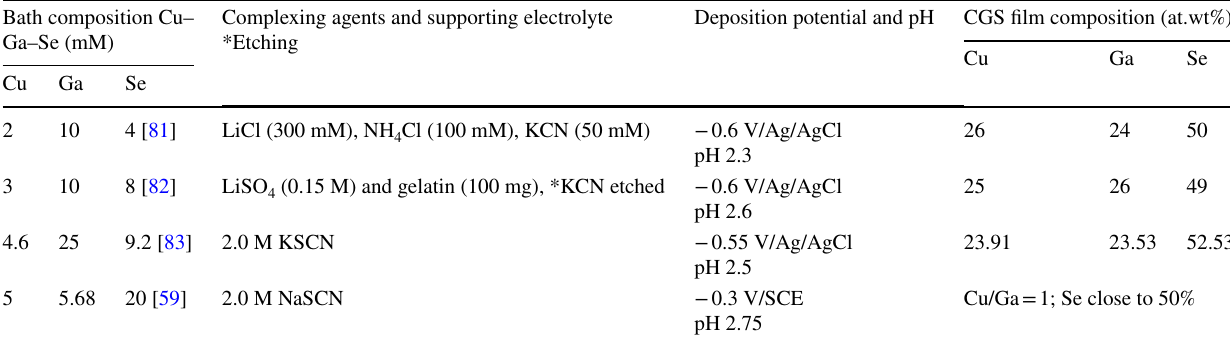
Deposition potential and